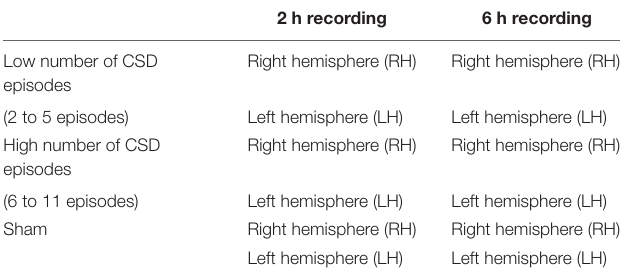
TABLE 1 | Experimental animal groups in which the contralateral ( n = 6) and the ipsilateral ( n = 6) hemispheres were analyzed with two recording durations (2 and 6 h) and three levels of cortical spreading depression (CSD) episodes.